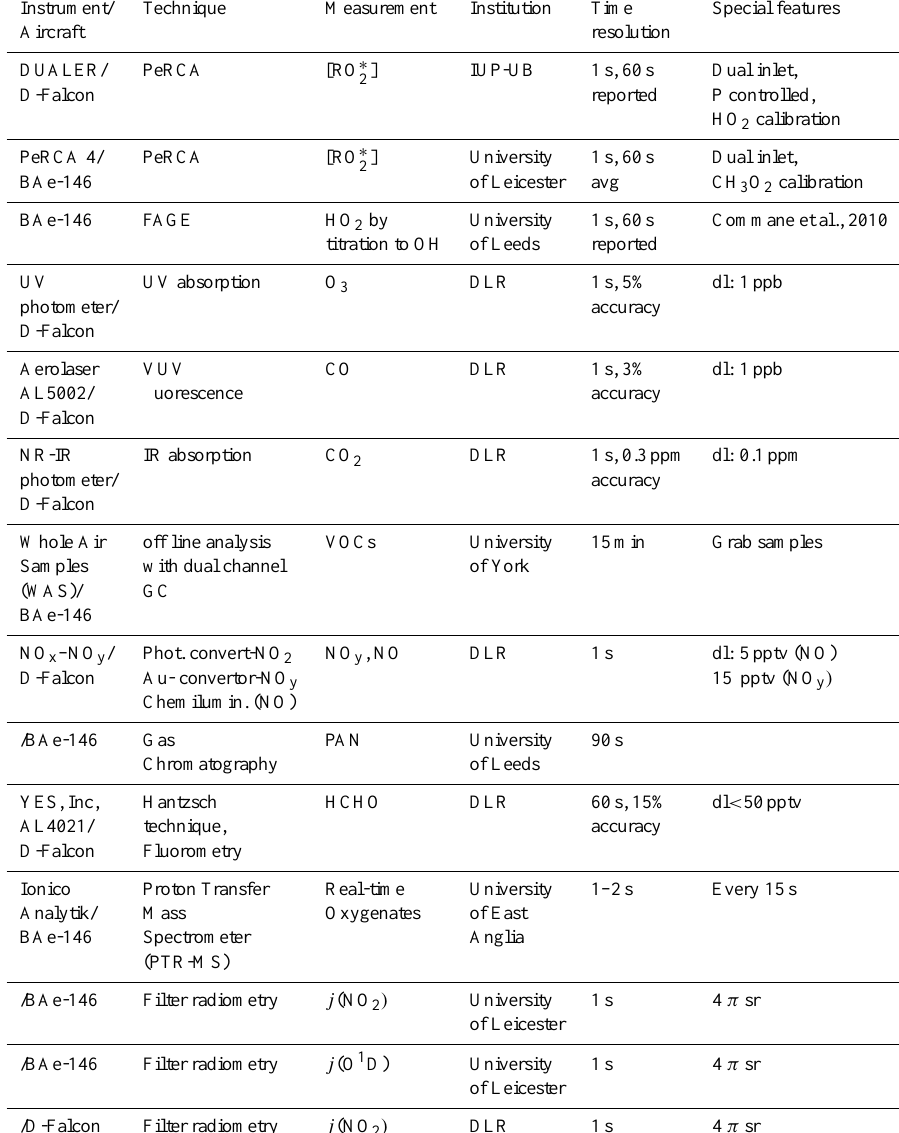
Table 1. Summary of the measurement techniques deployed during the AMMA peroxy radical intercomparison exercise, [RO ∗ ]=([HO 2 ]+ 6 [RO 2 ]); dl: detection 2